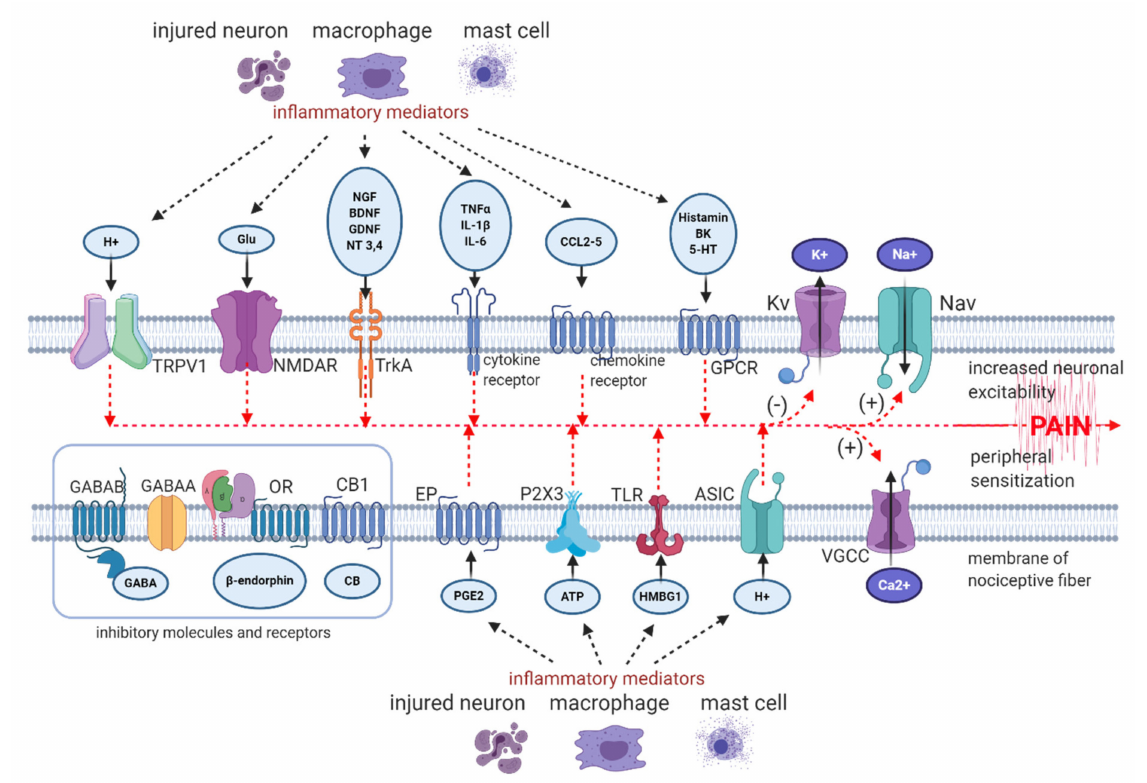
Figure 1. Neuronal ion channels, receptors and their ligands involved in peripheral neuroinflammation and sensitization. ( − ) Downregulation of Kv and K+ currents, (+) upregulation of Nav, VGCC, and Na + and Ca 2+ currents, respectively